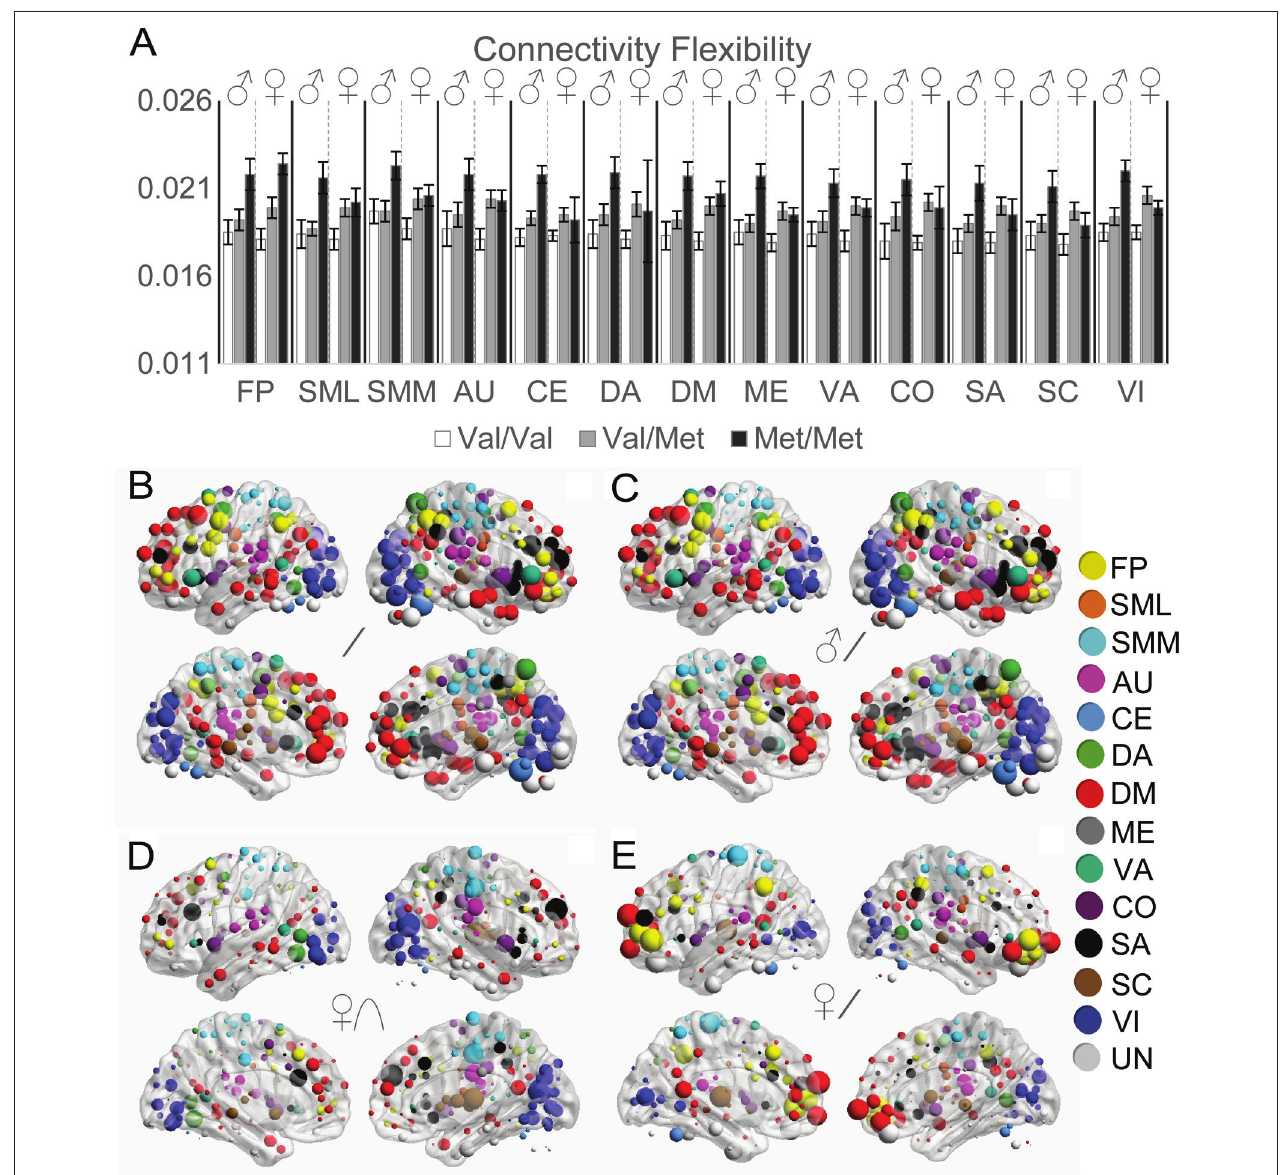
FIGURE 5 | Effects of COMT genotype and sex on functional connectivity flexibility between resting and task states. (A) Functional connectivity flexibility is plotted by COMT genotype and sex for each large-scale network. For display purposes, connectivity flexibility was averaged across all ROIs in a given network. Error bars reflect standard errors of the means. The strength of COMT genotype effects for each of the 264 ROIs is displayed on left and right cerebral hemispheres according to statistical tests of (B) linear effects across all subjects, controlling for sex, (C) linear effects in males, (D) quadratic effects in females, and (E) linear effects in females. The size of the spheres correspond with the size of the COMT genotype effects, scaled independently for each of the image sets in (B–E) . AU, auditory; CE, cerebellar; CO, cingulo-opercular task control; DM, default mode; DA, dorsal attention, FP, fronto-parietal task control; ME, memory retrieval; SA, salience; SML, lateral sensorimotor; SMM, medial sensorimotor; SC, subcortical; VA, ventral attention; VI, visual.